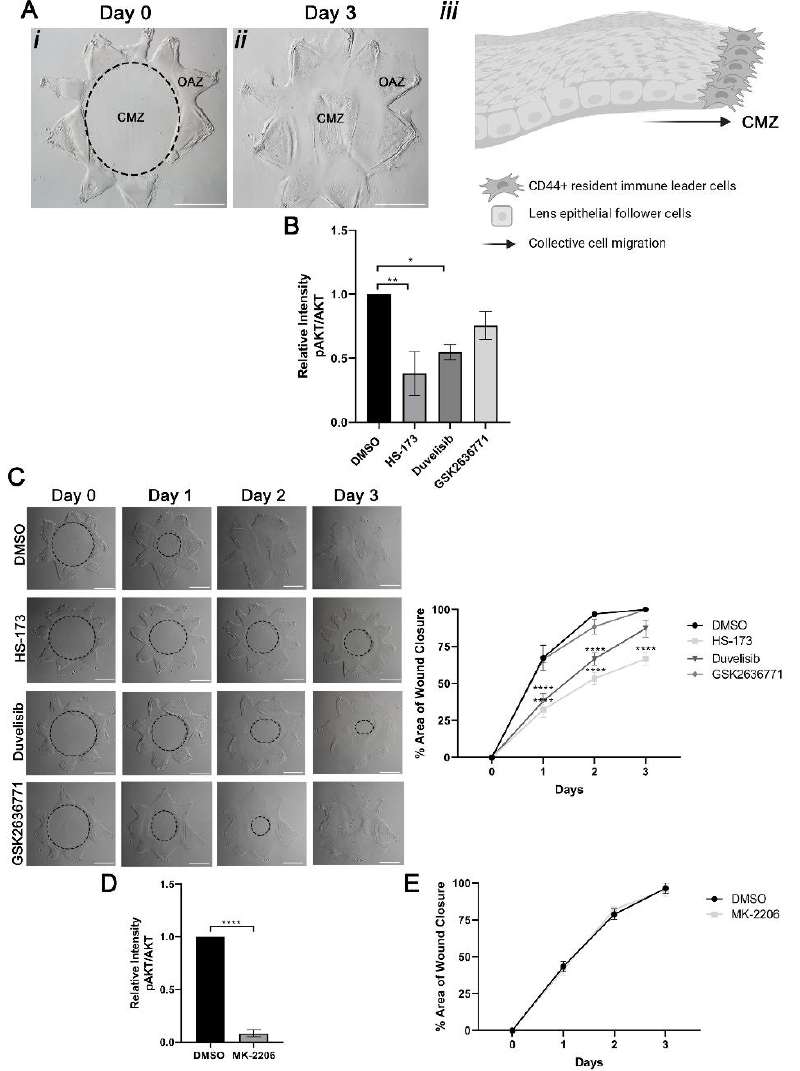
Figure 1. Wound healing in response to cataract surgery injury occurs in a PI3K isoform-specific manner. ( A ) Depiction of ex vivo post-cataract surgery culture to study mechanisms of wound repair across the cell-denuded endogenous basement membrane in the center of the lens capsule. Ex vivo post-cataract surgery explant on day 0 depicts the wounded lens epithelial cells within the original attachment zone (OAZ) and the cell-denuded central migration zone (CMZ) (i). In response to injury, collective migration across the endogenous basement membrane in the CMZ is driven by leader cells that direct the migration of the wounded epithelial follower cells (ii), arrow depicts the direction of wound healing. Collective migration across the CMZ for wound repair is completed by day 3 post-injury (iii). ( B , C ) Ex vivo post-cataract surgery explants were treated from Time 0 through Day 3 with individual PI3K isoform inhibitors, HS-173 for p110 α ; GSK2636771 for p110 β ; or Duvelisib for p110 δ / γ . ( B ) Graph from Wes analysis depicts the efficacy of individual PI3K isoform inhibitors compared to vehicle control by examining the relative intensity of the PI3K effector, phosphorylated- AKT (pAKT) relative to total AKT expression compared to GAPDH (loading control). ( C ) Phase microscopy shows open wound area (dotted black circle) for vehicle vs. PI3K inhibitor treatment from Day 0 through Day 3. Graph depicts % area of wound closure. Results show that blocking p110 α with HS-173 had the largest impact on inhibiting wound closure. ( D , E ) Ex vivo